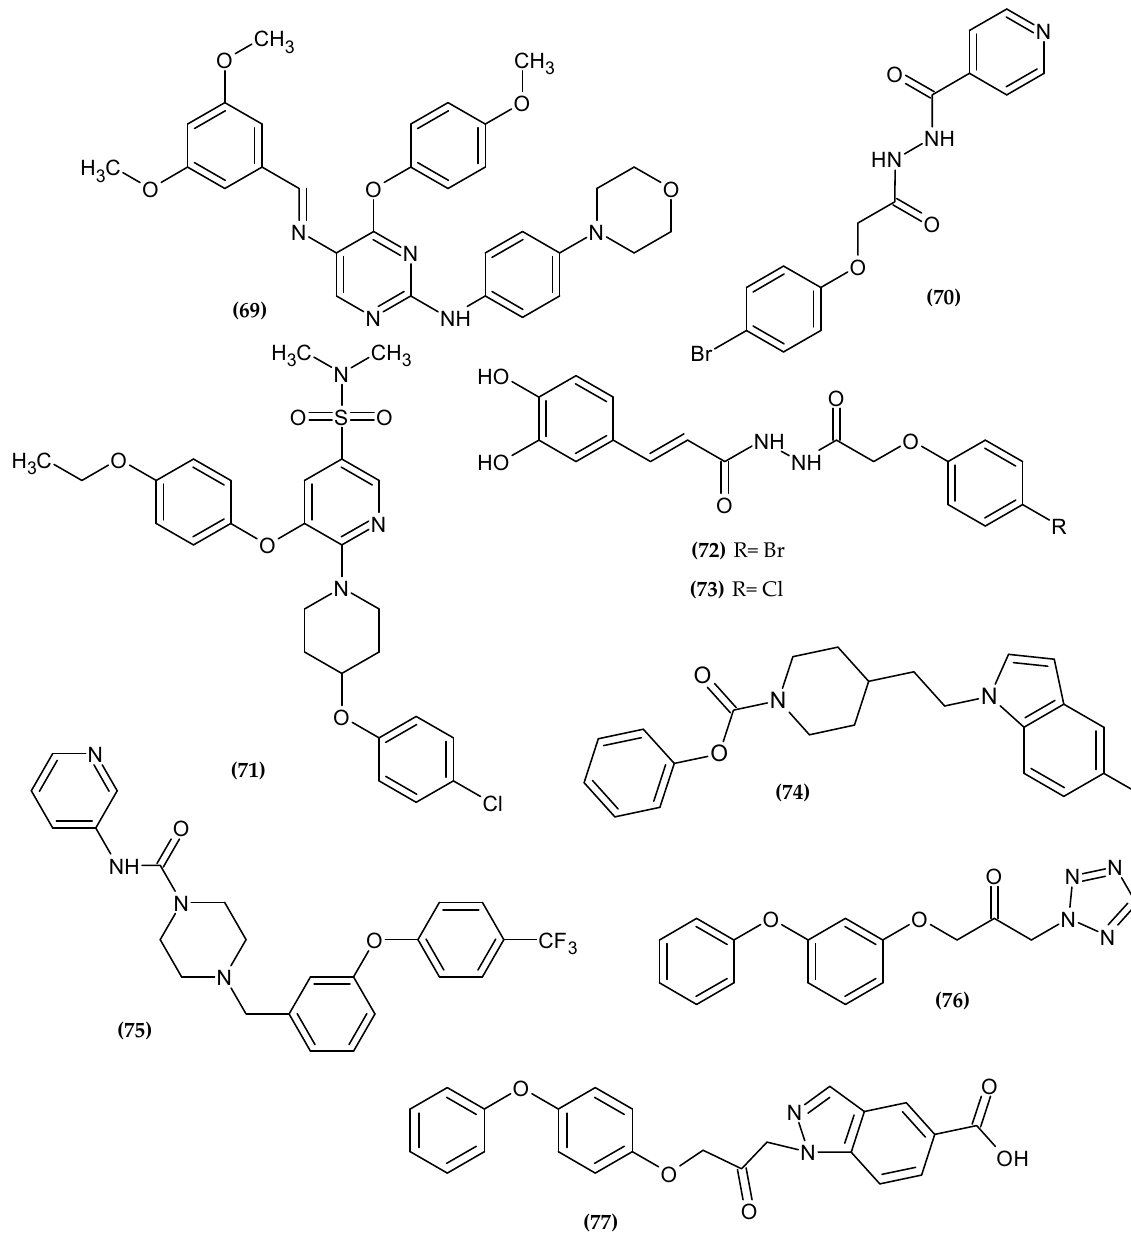
Figure 23. The novel potential agents with analgesic activity bearing a phenoxy group.